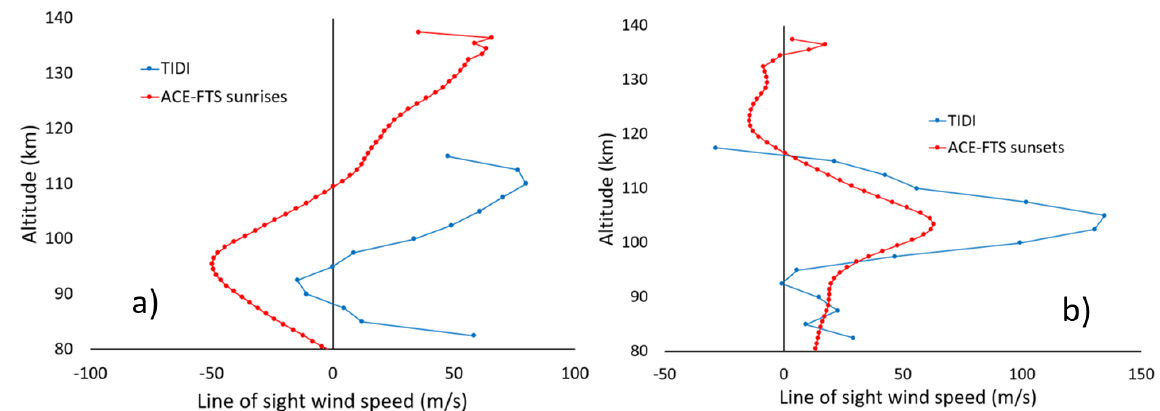
Figure 6. Average wind profiles for TIDI (in blue) and ACE-FTS (in red) coincident results from January to June 2020. ( a ) Results for ACE-FTS sunrises; ( b ) Results for ACE-FTS sunsets.